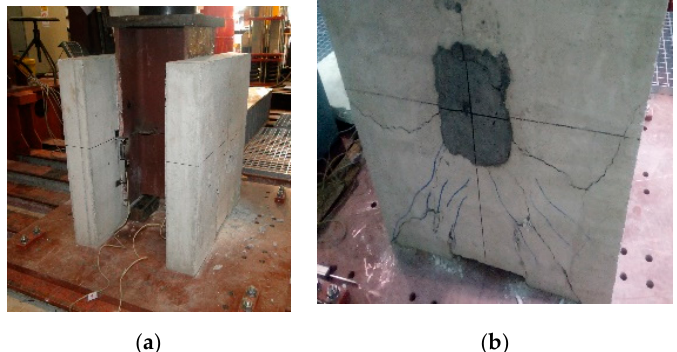
Figure 8. The specimen in the testing machine ( a ) and ultimate failure cracking ( b ).